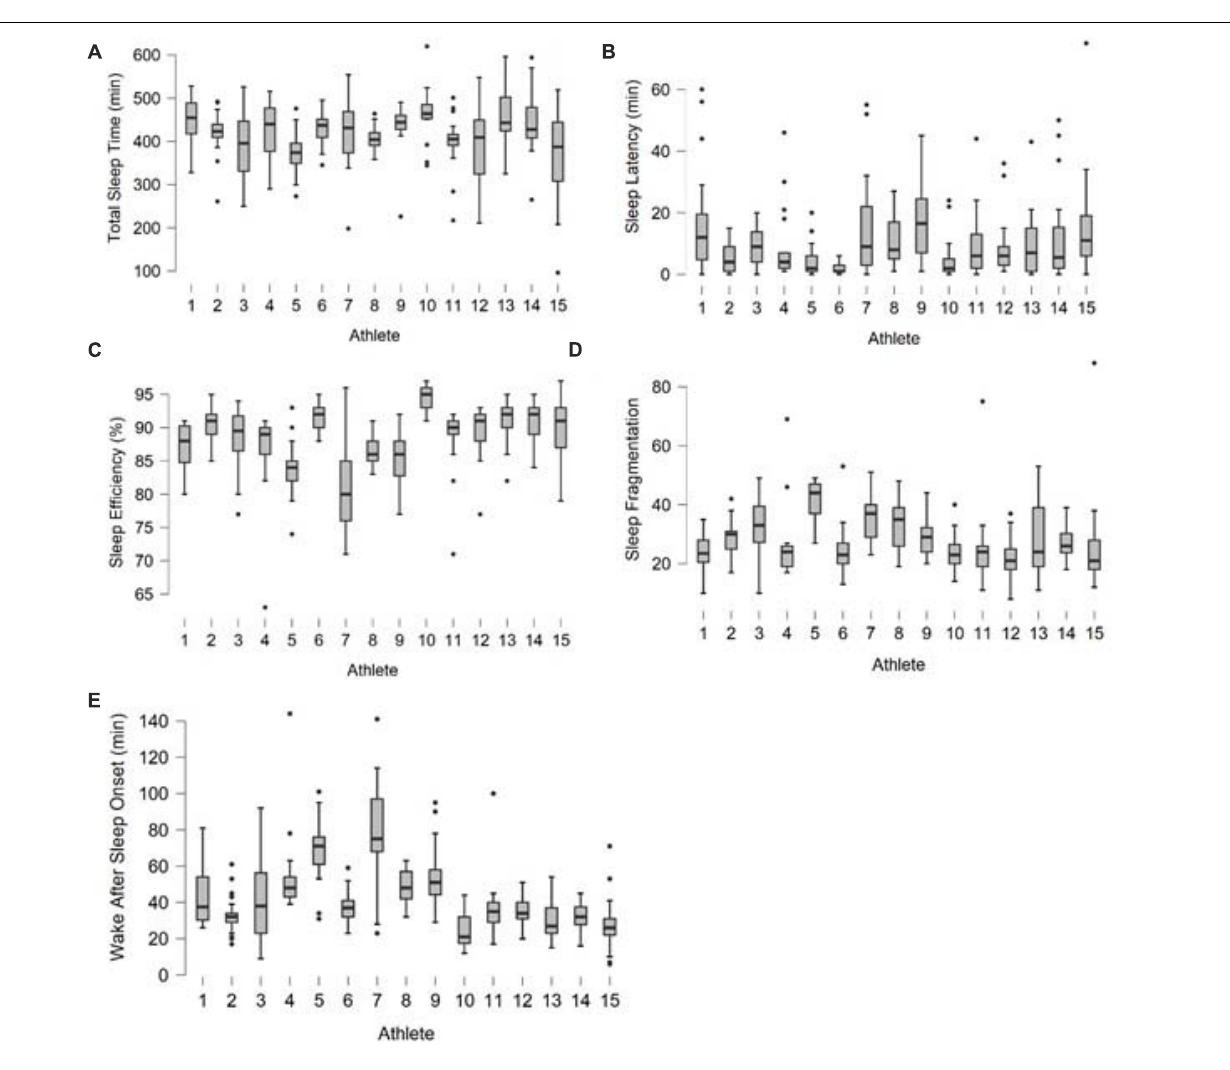
FIGURE 2 | Individual athlete total sleep time (A) , sleep onset latency (B) , sleep efficiency (C) , sleep fragmentation (D) and wake after sleep onset (E) during the study